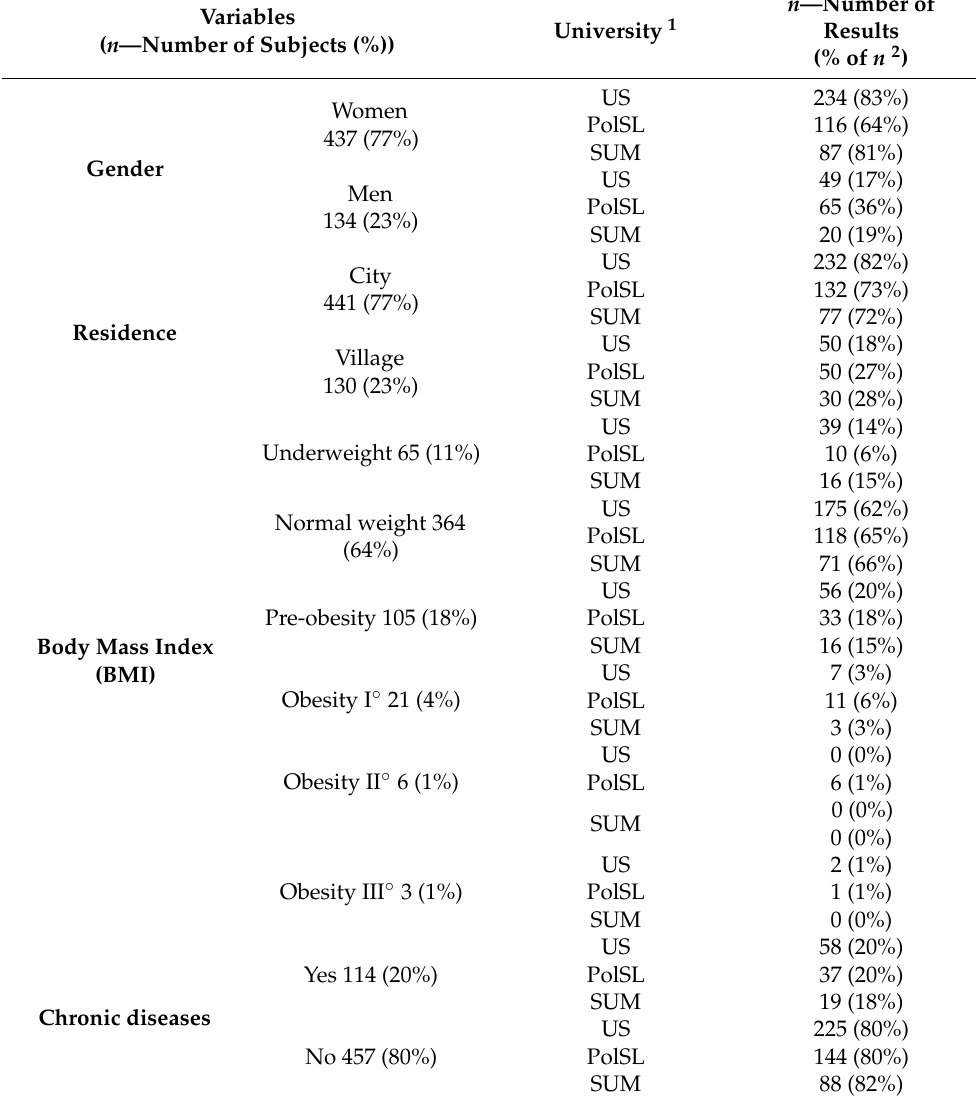
Table 1. Characteristics of the studied group of students from the Silesian province. Source: own study . Variables ( n —Number of Subjects